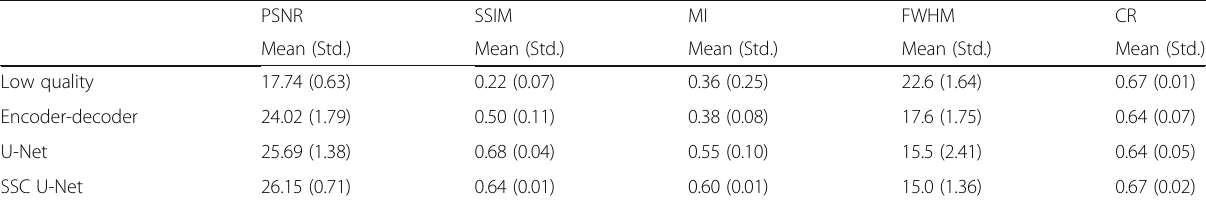
Table 1 Results of the three models on simulation dataset PSNR